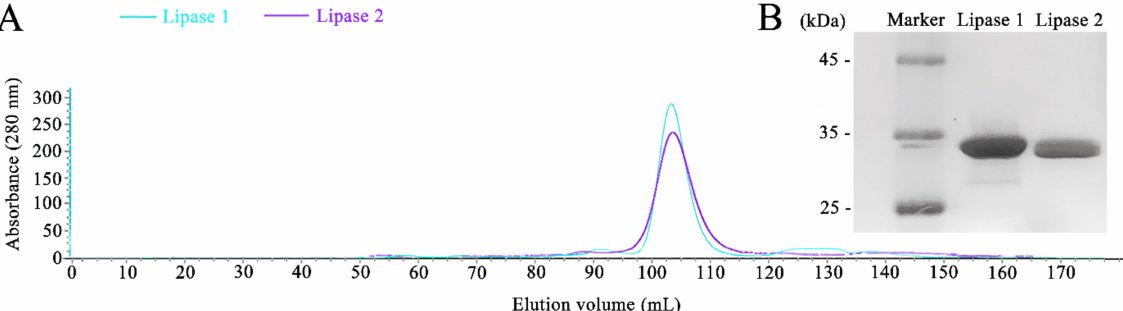
Figure 2. Purification of overexpressed Lipase 1 and Lipase 2 in E. coli cells. ( A ) Gel filtration chromatographies of Lipase 1 and Lipase 2 after purification by the Hiload TM 16/600 Superdex TM 200 column. ( B ) SDS-PAGE analysis of the purities of Lipase 1 and Lipase 2. Lane 1, standard molecular weight markers; lane 2, purified Lipase 1; lane 3, purified Lipase